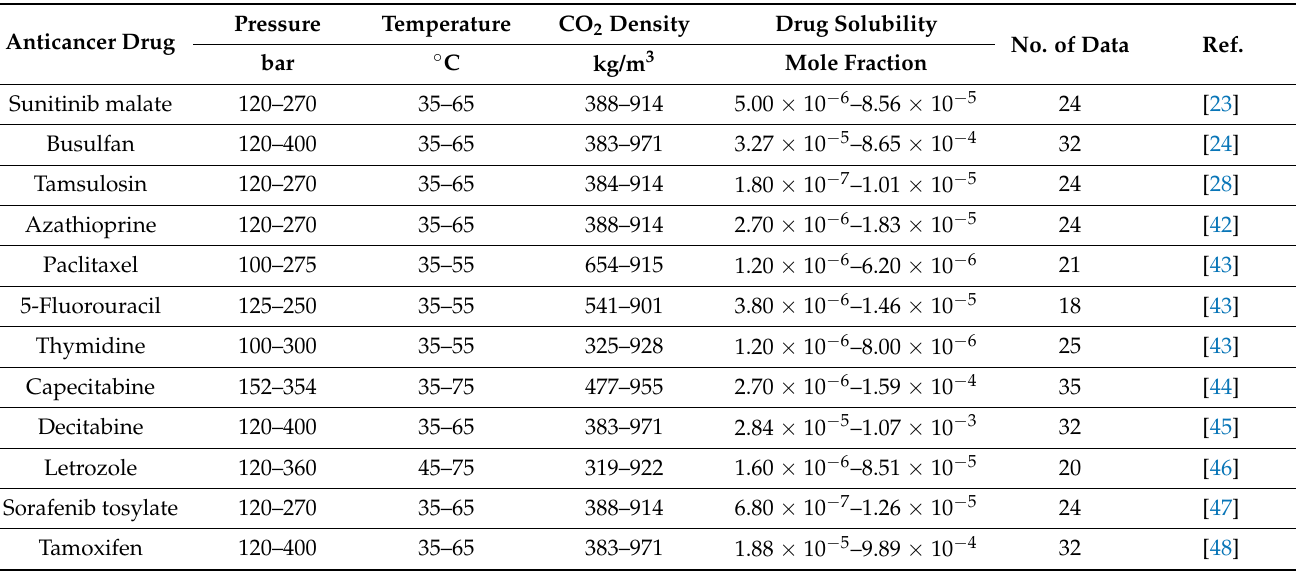
Table 1. Experimental data reported in the literature for the solubility of anticancer drugs in super- critical CO 2 .